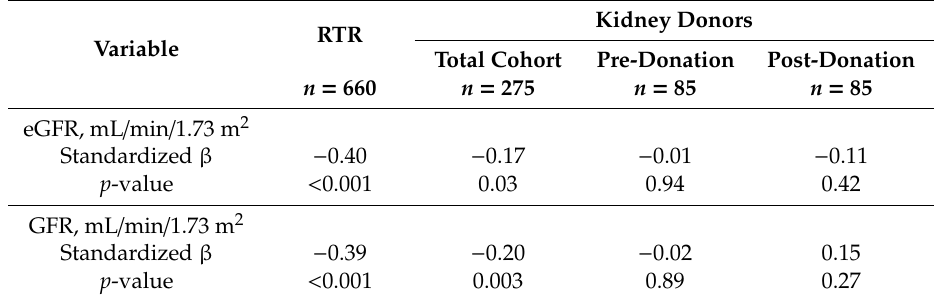
Table 2. Associations of urinary 2Py/ N 1 -MN with kidney function in RTR and kidney donors before and after kidney donation 1 .